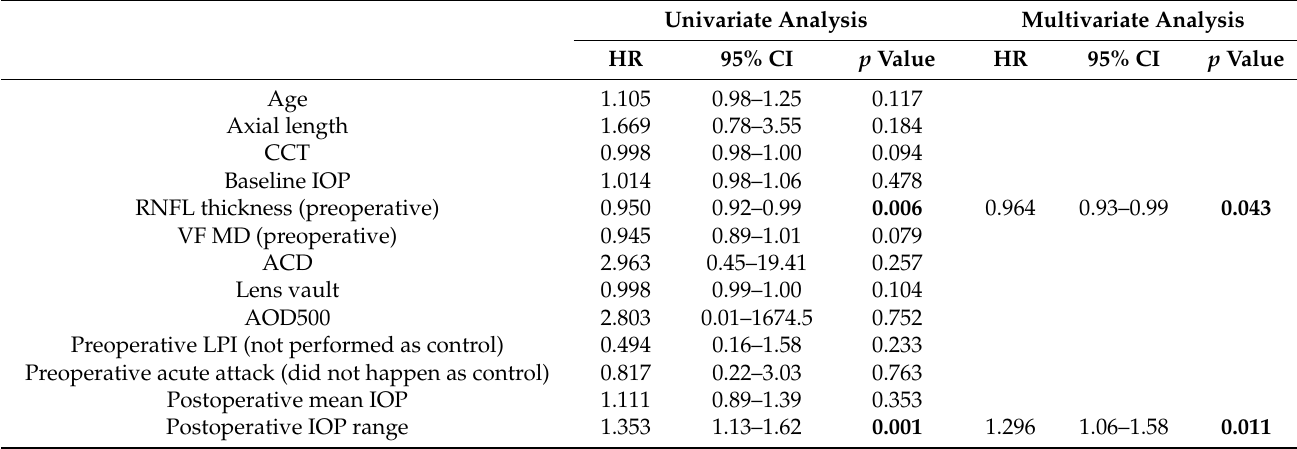
Table 6. Cox proportional hazards model to determine clinical variables associated with visual field progression in primary angle closure